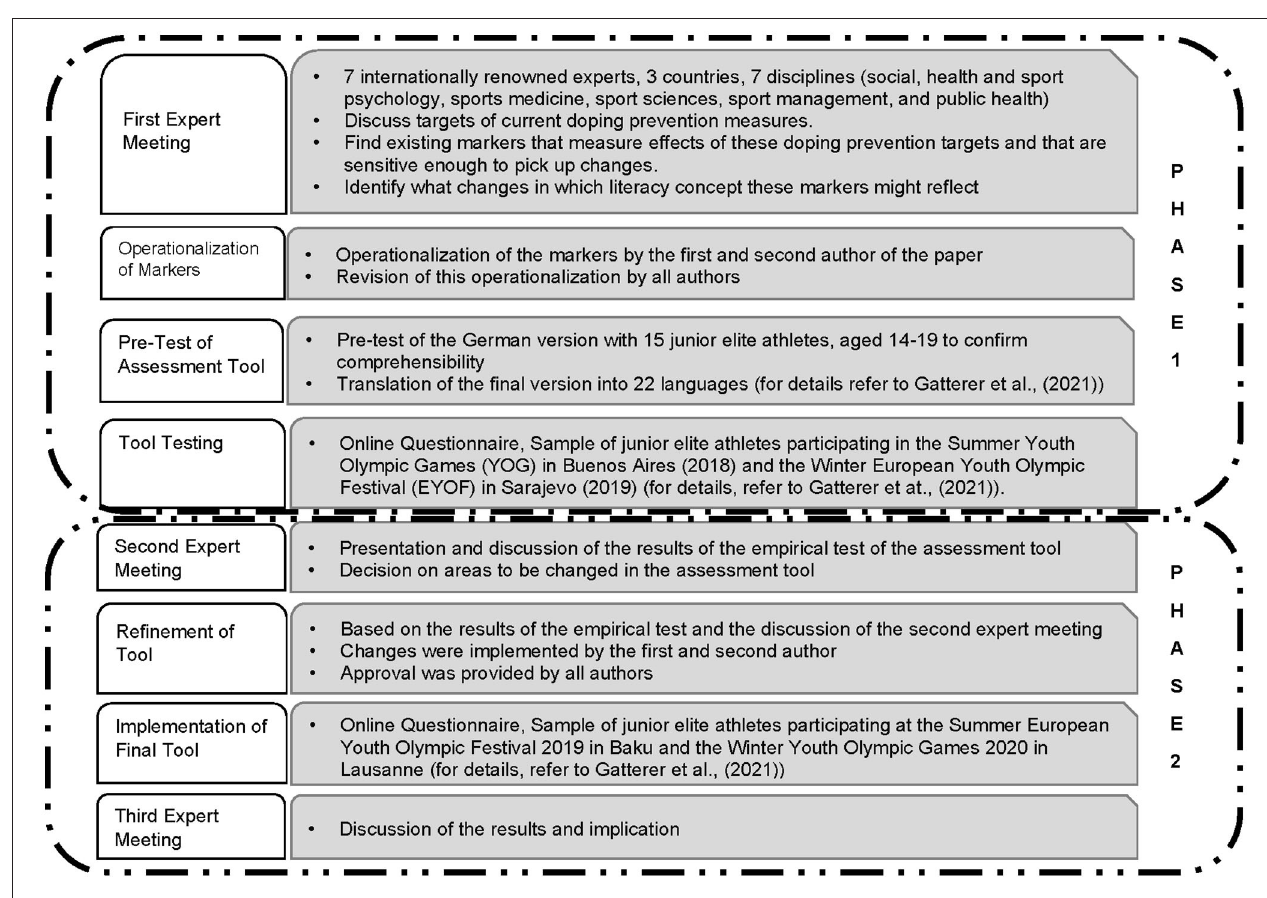
FIGURE 3 | Description of the procedure and data collection for phases one and